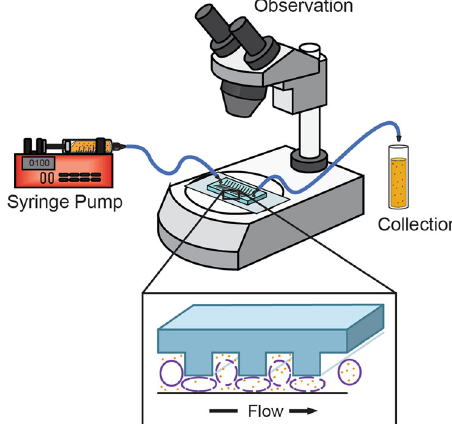
Fig. 1 Experimental setup for cell volume exchange for the convective transfer, VECT. A syringe pump delivers the target protein into HeLa cells as it passes through the micro fl uidic